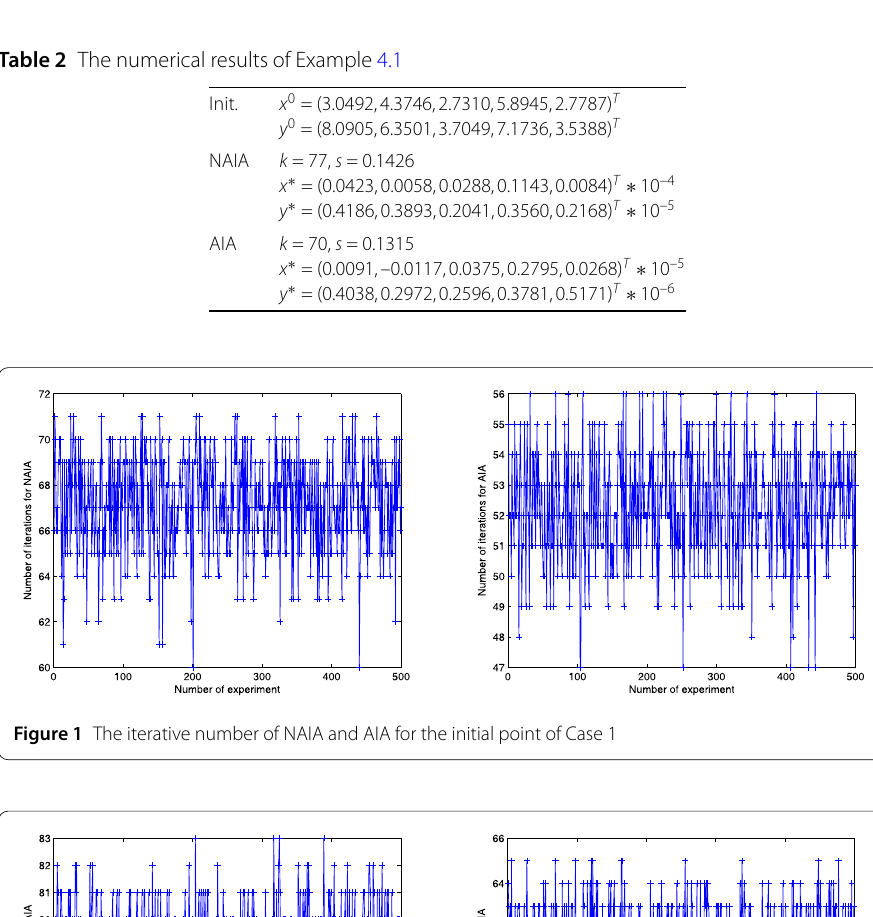
Case 1. x 0 = rand (5,1) , y 0 = rand (5,1)